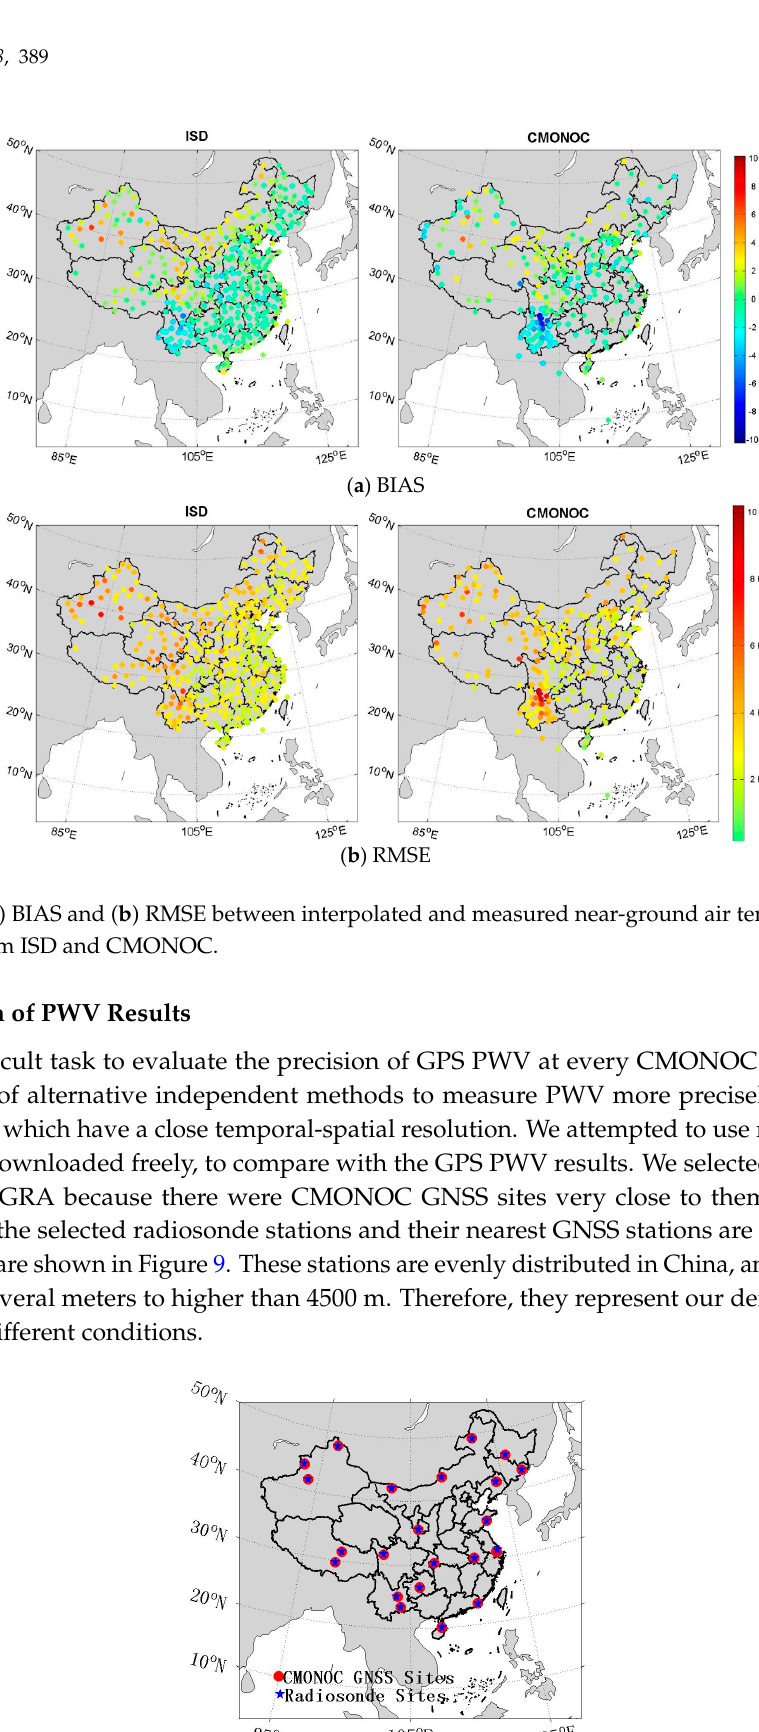
Figure 9. Distribution of radiosonde and GNSS stations that were selected to compare their PWV results.